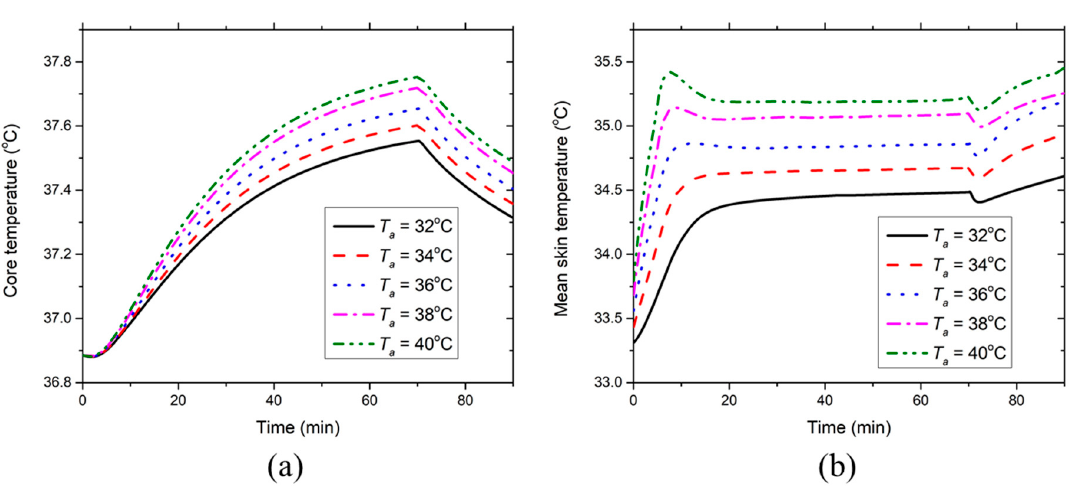
Figure 6. E ff ect of environmental temperature on the time course of ( a ) core temperature and ( b ) mean skin temperature at RH = 50%.